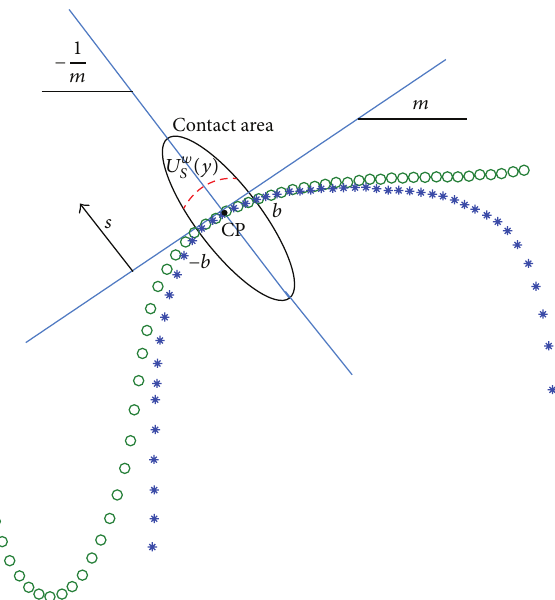
Figure 4: Method adopted to remove the material from the